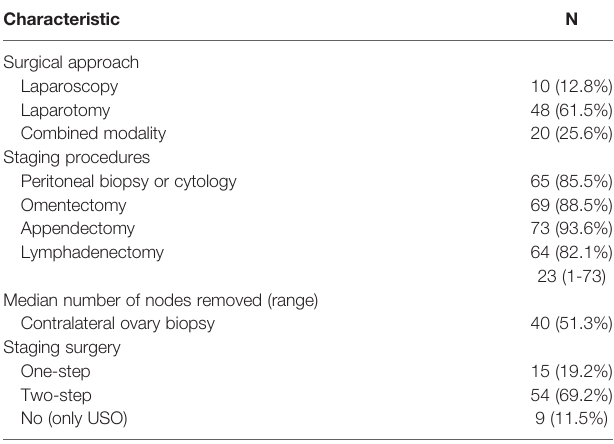
TABLE 2 | Characteristics of initial surgery in the FSS group